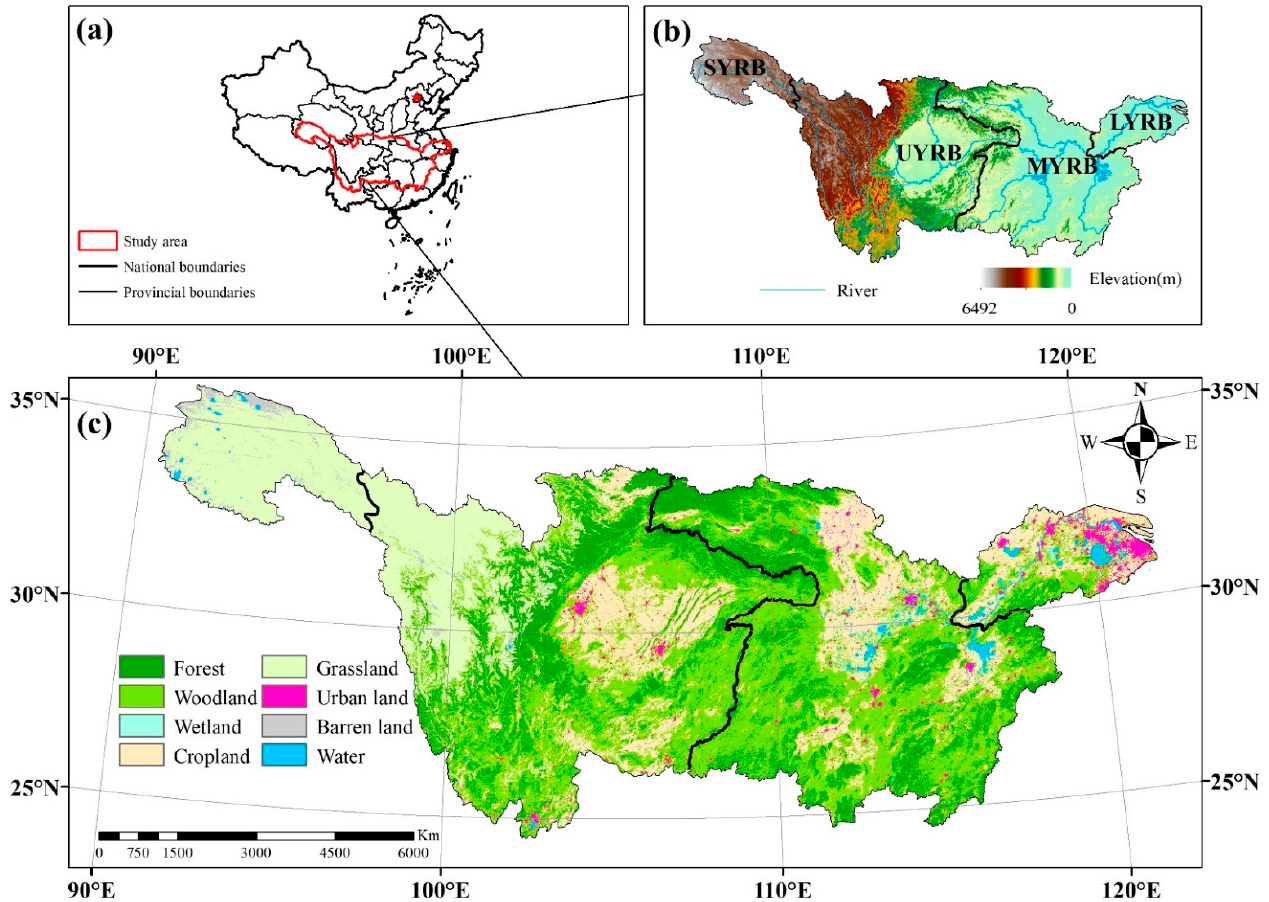
Figure 1. ( a ) The location of the Yangtze River Basin in China. ( b ) Four sub-basins: the source of the YRB (SYRB), the upper reaches of YRB (UYRB), the middle reaches of YRB (MYRB) and the lower reaches of YRB (LYRB). ( c ) Land cover types in 2020 and the 8 classes derived from 17 classes of IGBP.